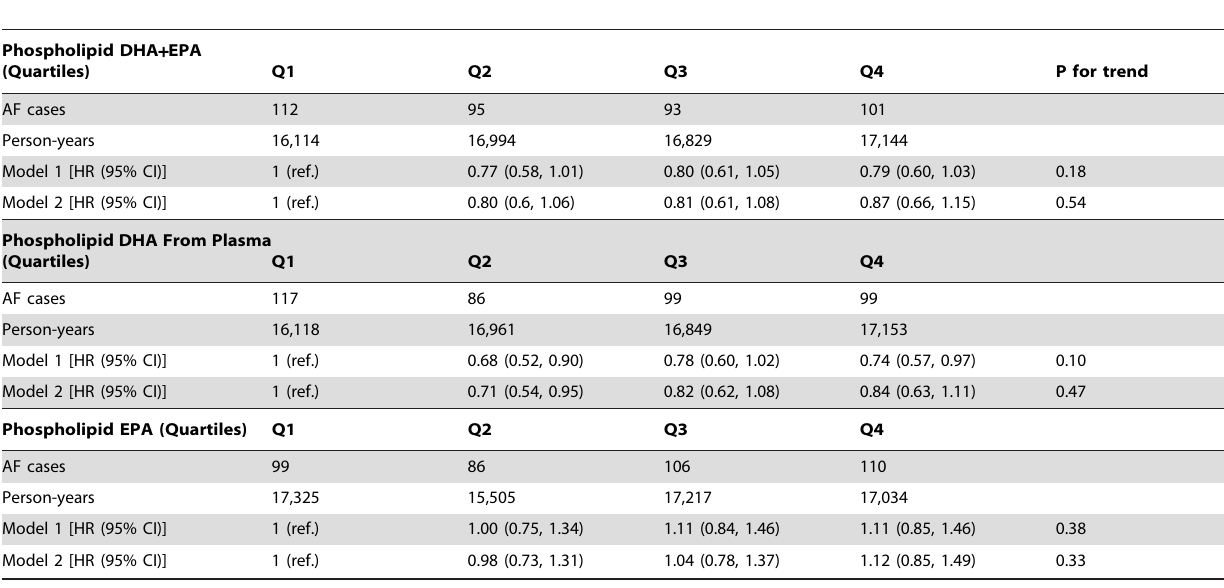
Table 4. Hazard ratios (95% confidence interval) of atrial fibrillation by quartiles of Phospholipid DHA and EPA, ARIC Minnesota field center,